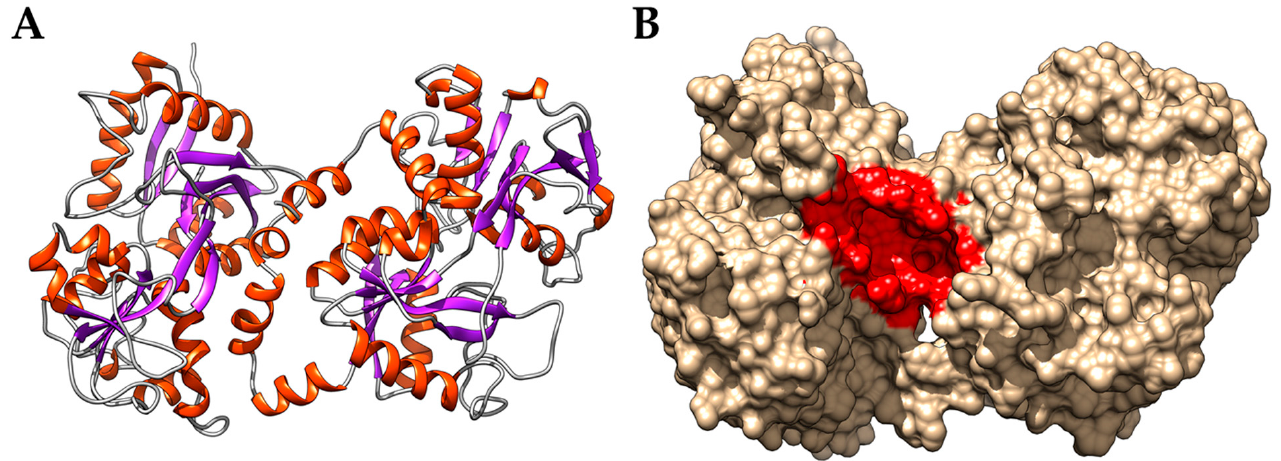
Figure 1. ( A ) Cartoon representation of the bovine LF structure. α -helices are represented as orange spirals, while β -strands through violet arrows. ( B ) Molecular surface representation highlighting the cavity (in red) identified in Huang et al., 2018, selected as a binding site for the molecular docking experiments.